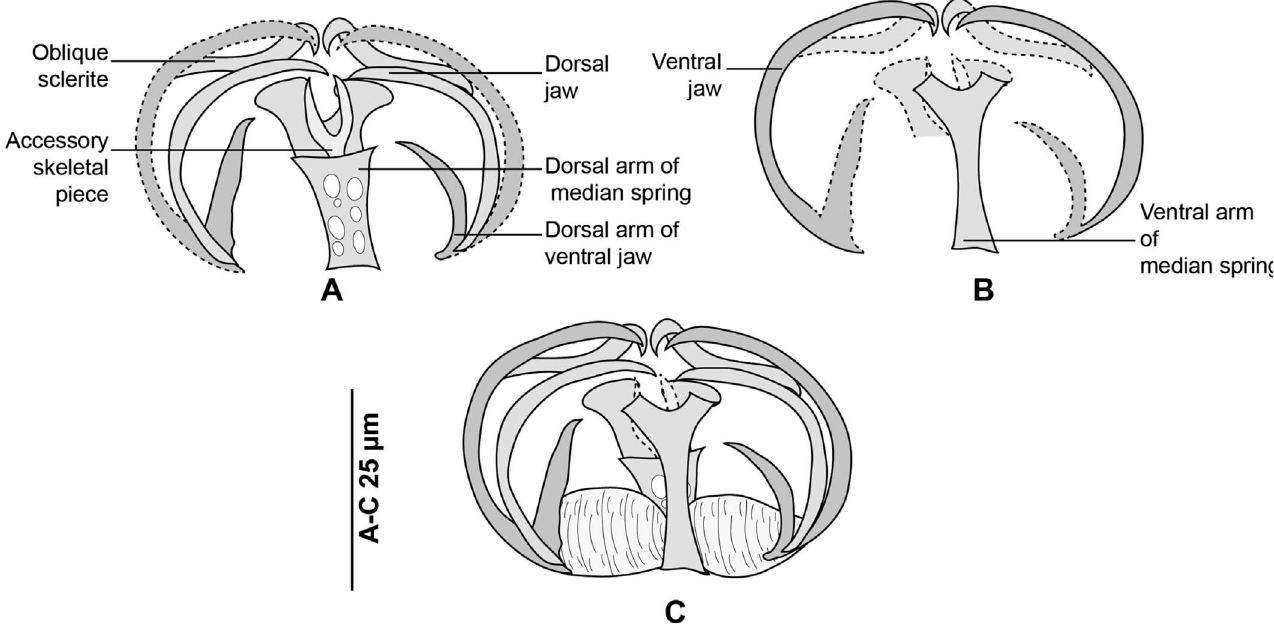
Figure 4. Clamp, with detailed legends, MNHN HEL1289 (A) Ventral jaw. (B) Dorsal jaw. (C) Whole